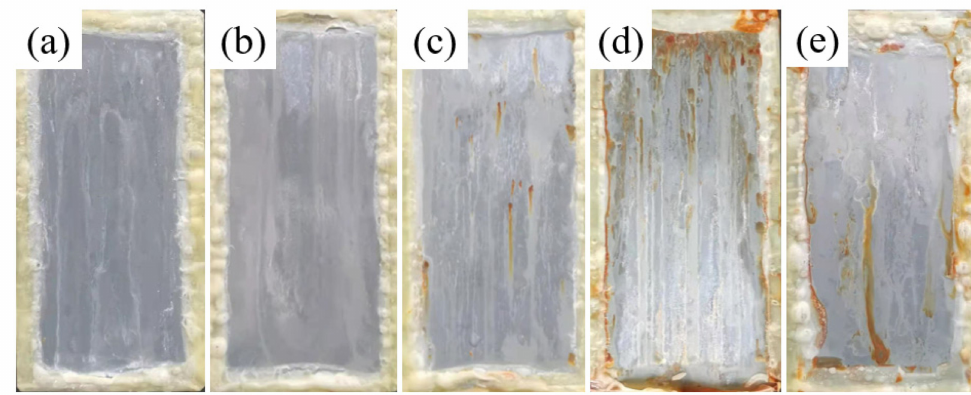
Figure 7. The optical images of WB zinc-based coatings after corrosion test at 1000 h in 5 wt.% NaCl: ( a ): 0H, ( b ): 6H, ( c ): 16H, ( d ): 20H and ( e ): 36H.